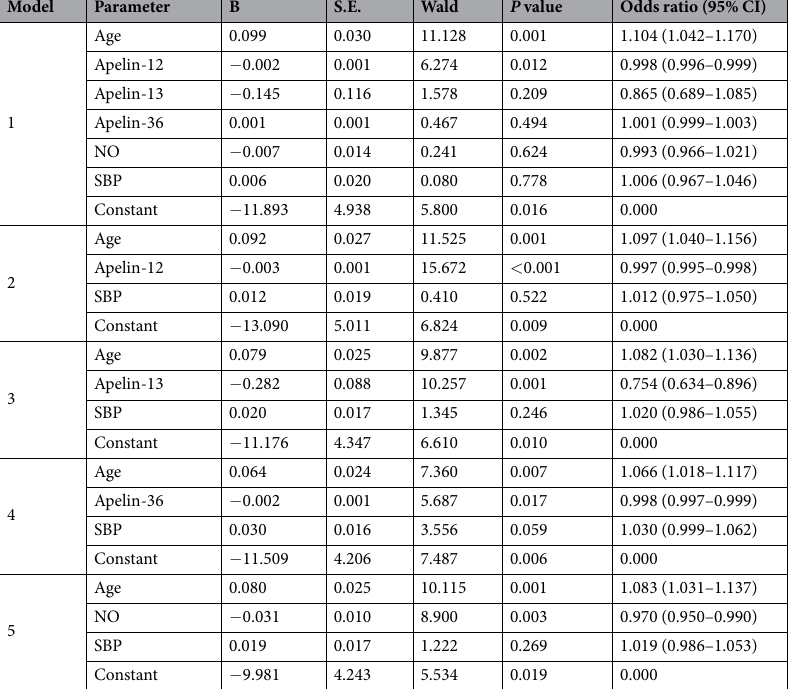
Table 3. Binary logistic regression analysis for MMD and ICAD groups. All regression models were adjusted by BMI, sex, cigarette smoking, and alcohol consumption. BMI, body mass index; SBP, systolic blood pressure; NO, Nitric oxide; MMD, moyamoya disease; ICAD, intracranial atherosclerotic disease.